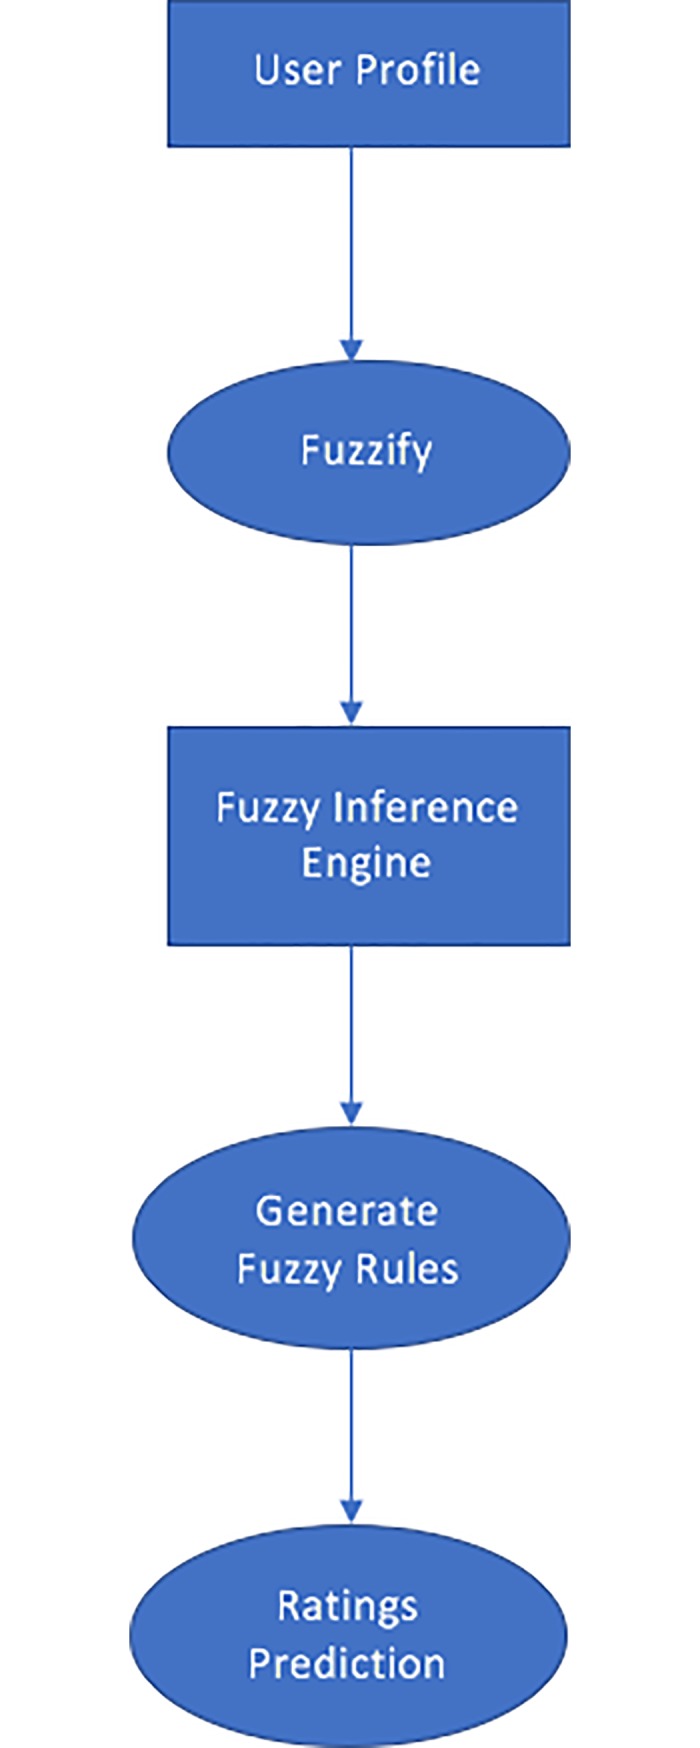
Fuzzy algorithm.